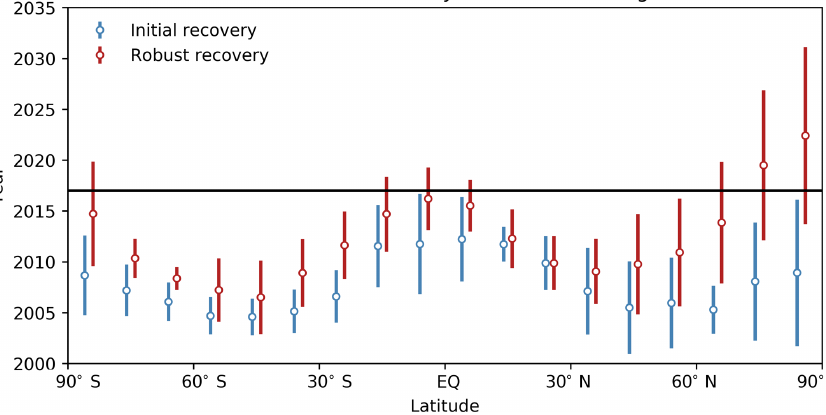
Figure 3. Year in which recovery trend of the ozone residuals becomes significant. A distinction is made for the first time significance can be determined (blue points) and the time after which trends remain significant (red points). Here trend significance is calculated using the trend uncertainty obtained when all ensemble members are used, as discussed in Sect. 3, but the trend magnitude is calculated for each ensemble member individually to reflect the impact of unaccounted for noise on the trend magnitude. Error bars represent the 95% confidence intervals, calculated as twice the standard deviation of the seven values obtained for the year that trend significance is identified (one for each ensemble